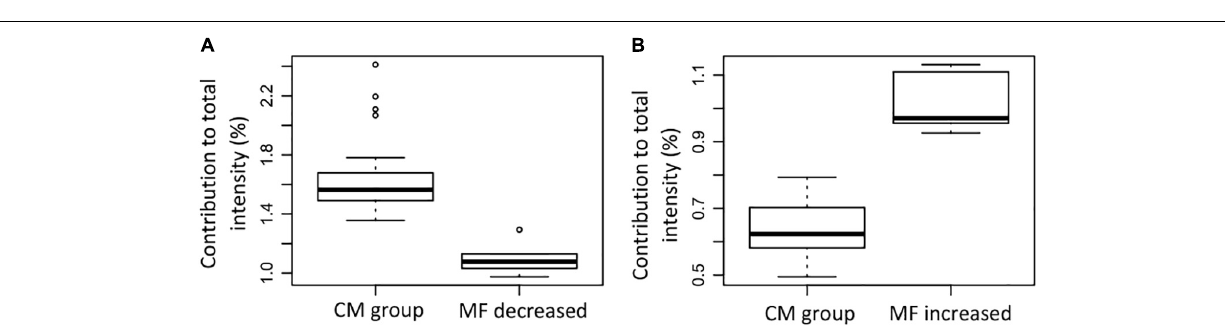
FIGURE 8 | Contribution to the total signal intensity of the (A) molecular formulae (MF) that were significantly decreased in the samples that lost SPE-DOC ( n = 6) compared to the conservative mixing group ( n = 27), and (B) the MF that were significantly increased in the samples that gained SPE-DOC ( n = 6) compared to the conservative mixing group ( n = 27). CM group: conservative mixing